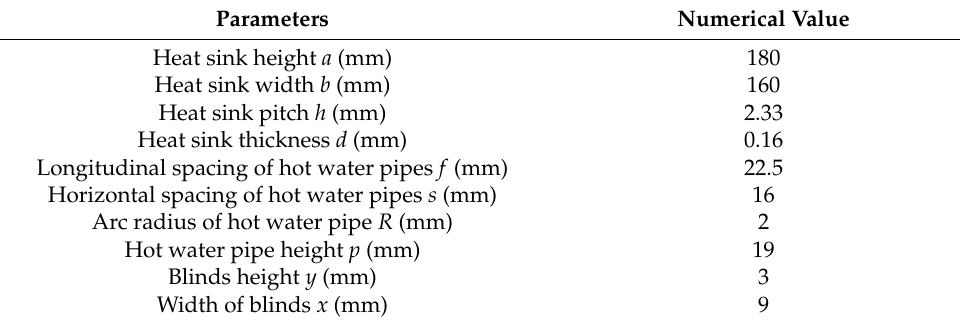
Figure 2. Structure diagram of the radiator fin. Table 1. Structure parameters of the radiator fin.